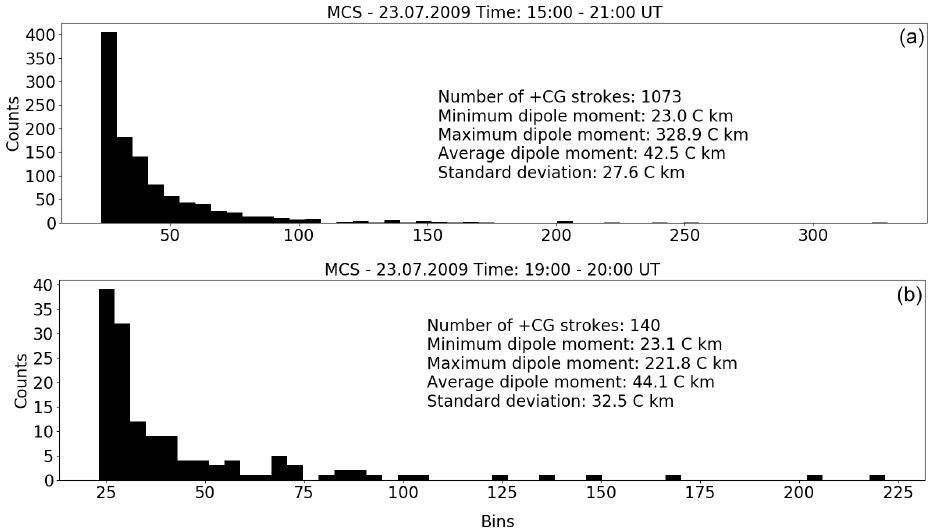
Figure 4. Histograms of charge moment distribution in the analysed MCSs for the whole activity period (a) and for the most inten- sive hour (b)